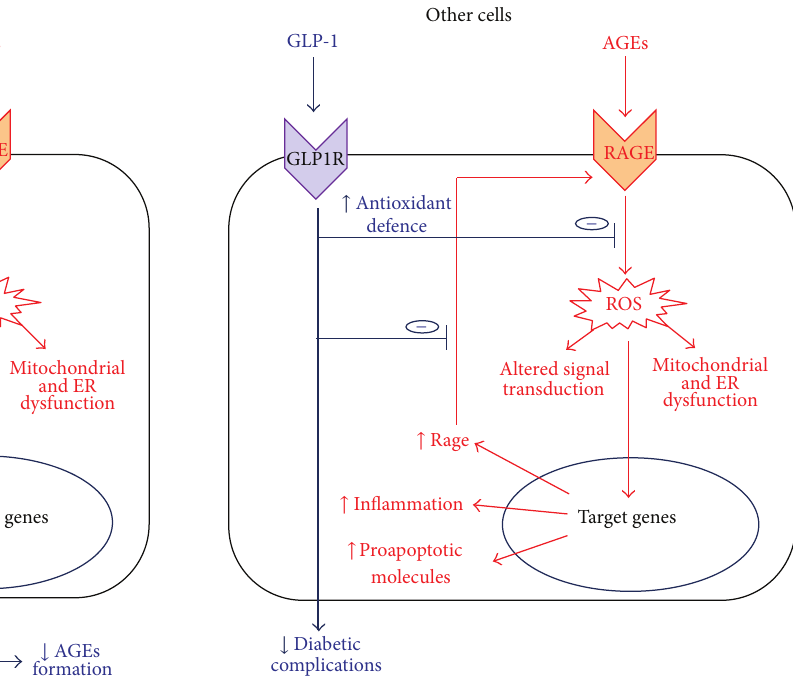
F1:Bene�cialeffectsofGLP-1inpancreaticbetacellsexposed to AGEs. e activation of the AGEs-RAGE axis in pancreatic beta cells increases oxidative stress that causes mitochondrial dysfunction, endoplasmic reticulum stress, and altered signal trans- duction. ese detrimental effects modify gene expression leading to increased expression of RAGE and proapoptotic molecules, and downregulation of proteins involved in insulin gene expression, such as PDX-1, thus causing decreased insulin production and loss of glucose-stimulated insulin secretion (GSIS). Activation of GLP- 1 signaling increases antioxidant defense thus counteracting for- mation of reactive oxygen species (ROS) and expression of RAGE, blocking the positive feedback loop that links RAGE activation withRAGEexpression.Furthermore,GLP-1maintainingpancreatic beta-cell function restores GSIS, thus contributing to reduce plasma glucose concentration and, consequently, formation of new AGEs.